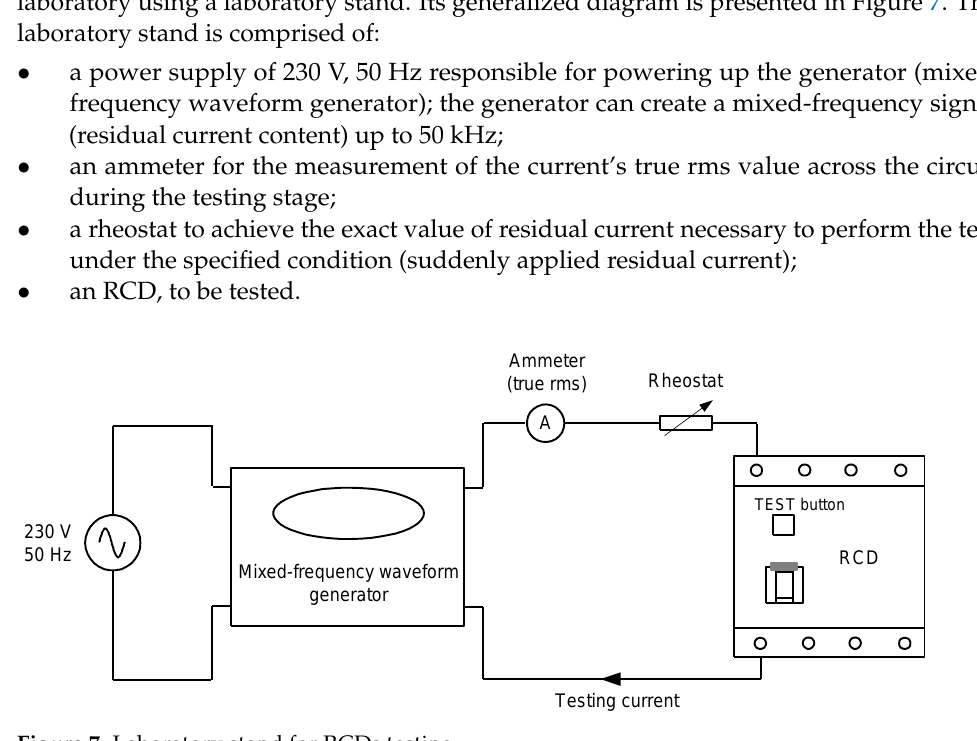
Figure 7. Laboratory stand for RCDs testing.